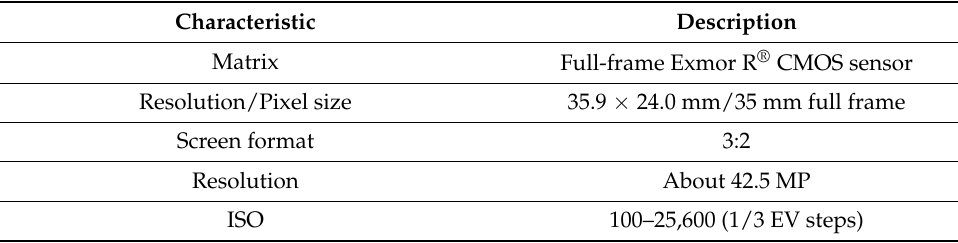
Table 2. Specifications of Sony RX1R II camera.